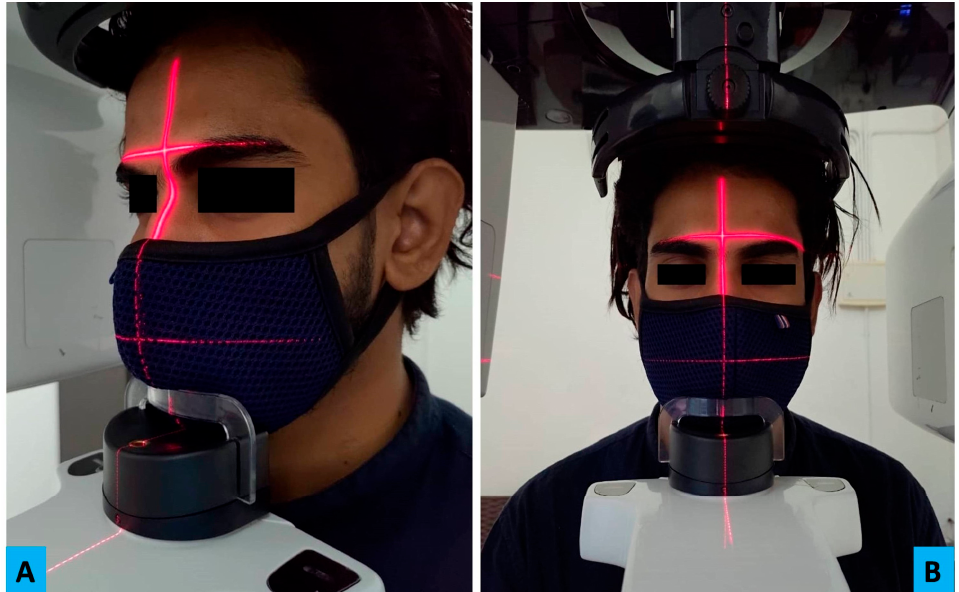
Figure 3. This figure depicts a patient’s lateral ( A ) and front ( B ) profile while being prepared for cone beam computed tomography (CBCT) imaging. Here, patient is shown wearing the face mask as a part of “new” infection control protocol. The red colour positioning lights can be seen assisting in the positioning of patient in the correct Sagittal and coronal plane.